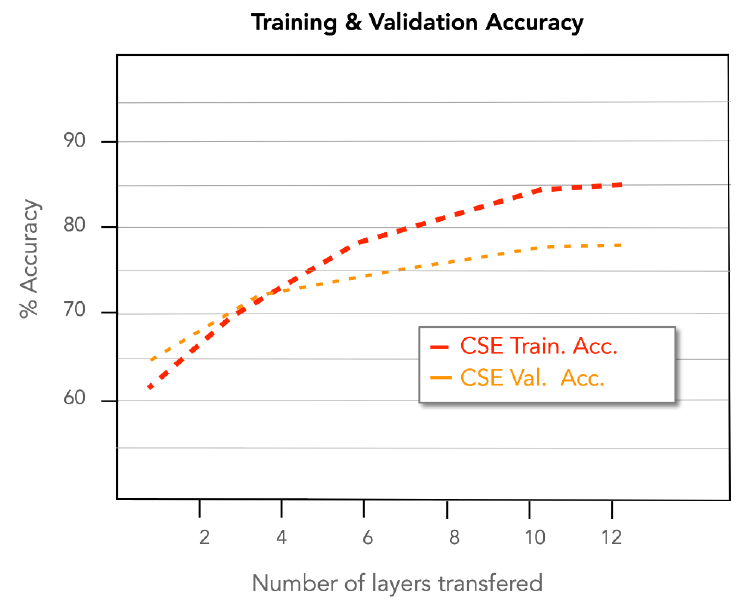
Figure 7. Performance improvement during transfer-learning.